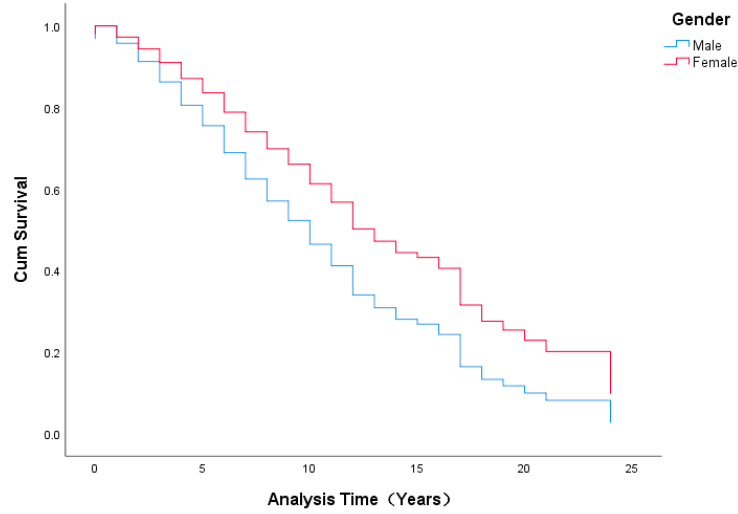
Figure 5. Survival Function for Gender in Promotion From Assistant to Associate Professor. Table 6. Means and Mediansof Promotion Duration of the Genders.